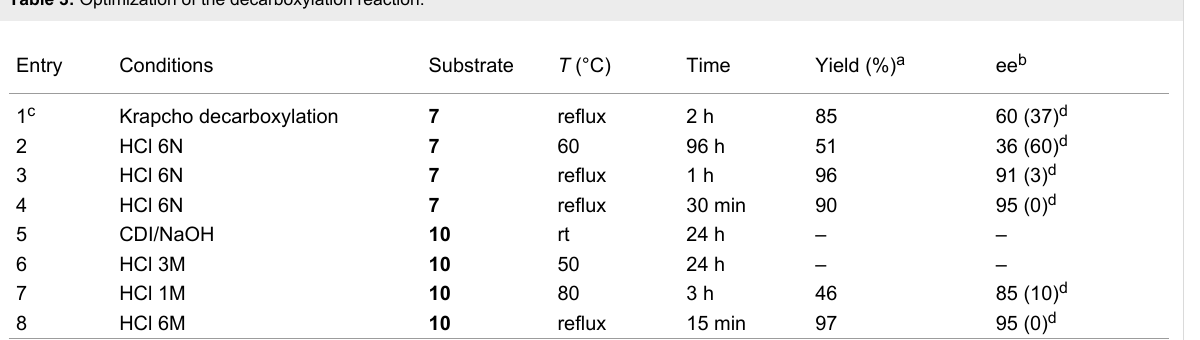
Table 3: Optimization of the decarboxylation